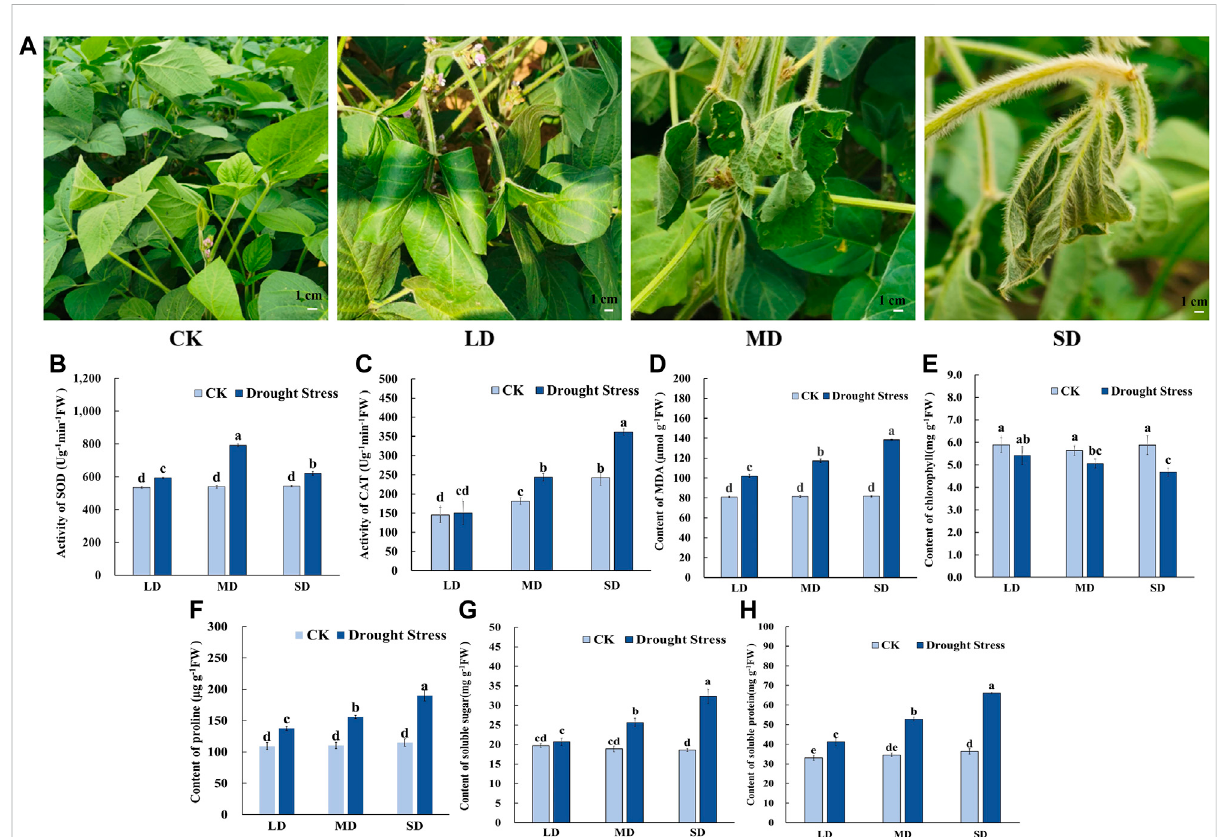
FIGURE 1 Phenotypic characteristics and physiological properties of soybean under drought stress. (A) Phenotypic characteristics of soybean under drought stress. (B) The activity of SOD. (C) The activity of CAT. (D) The content of MDA. (E) The content of chlorophyll. (F) The content of proline (G) The content of soluble sugars. (H) The content of soluble protein. Three biological replicates were performed and the data represent the means ± SDs. Different letters represent statistically signi fi cant differences ( p <